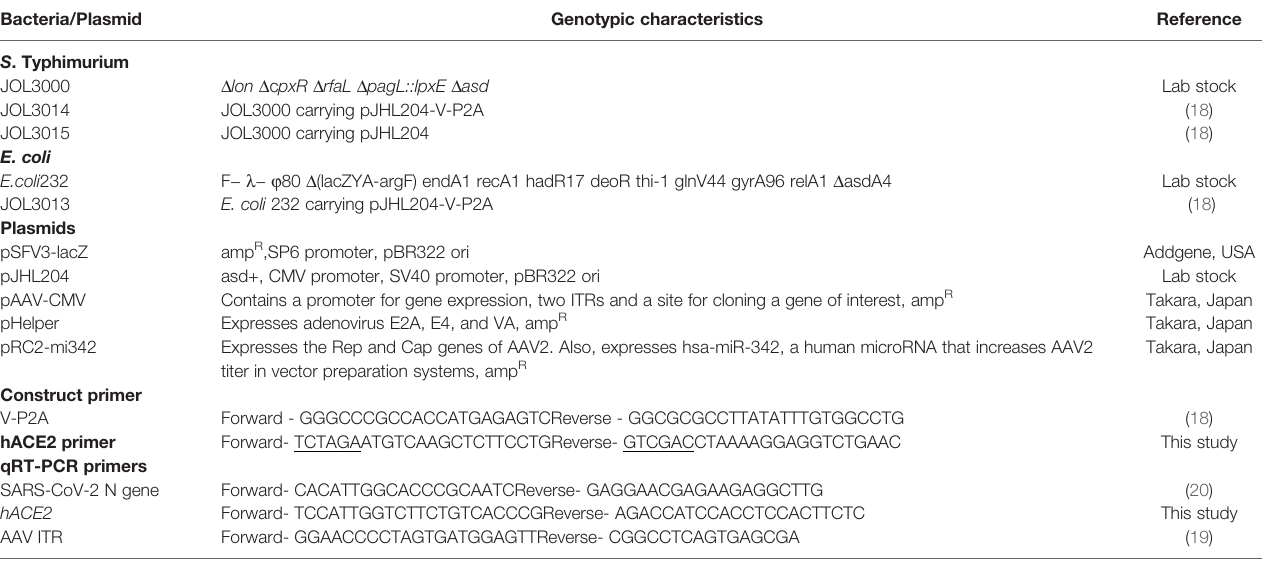
TABLE 1 | List of bacterial strains, plasmids and primers used in the present study.